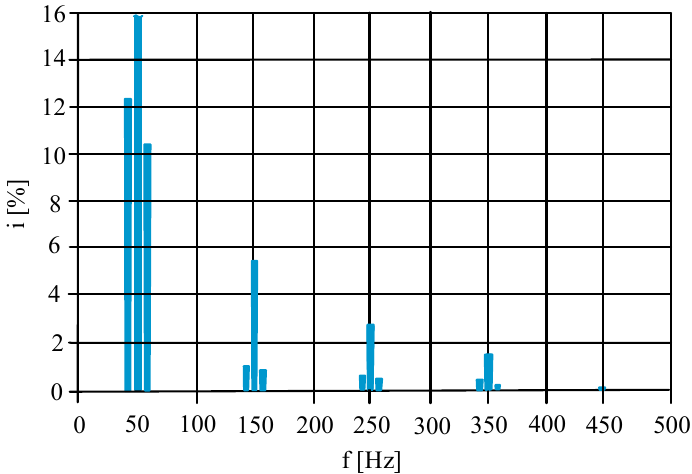
Figure 3. Current spectrum of motor 1 supplied with the voltage containing the positive sequence subharmonic of frequency f sh = 43 Hz.